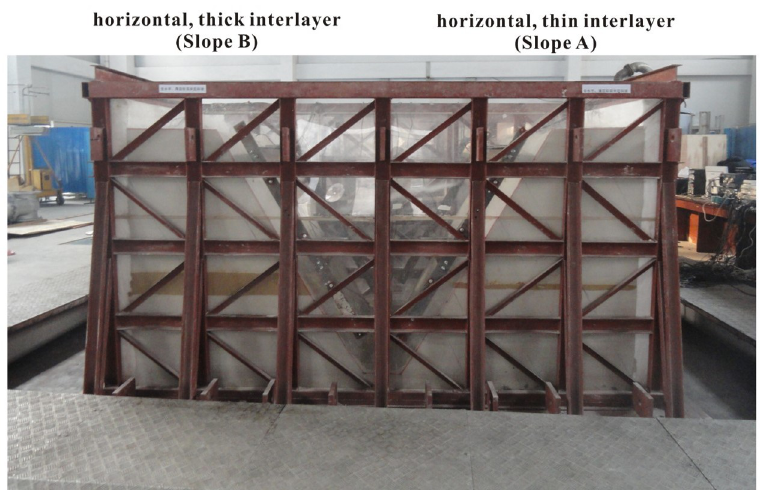
Fig 1. Two model slopes with a weak interlayer with different